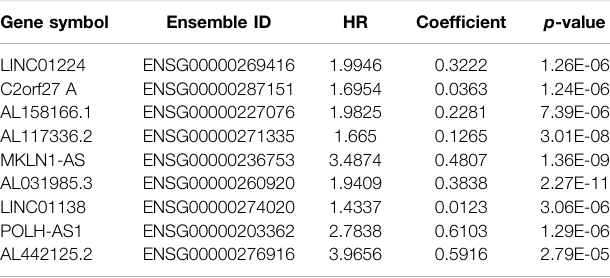
TABLE 1 | Nine lncRNAs signi fi cantly correlated with the overall survival of hepatocellular carcinoma. Gene symbol Ensemble ID HR Coef fi cient p